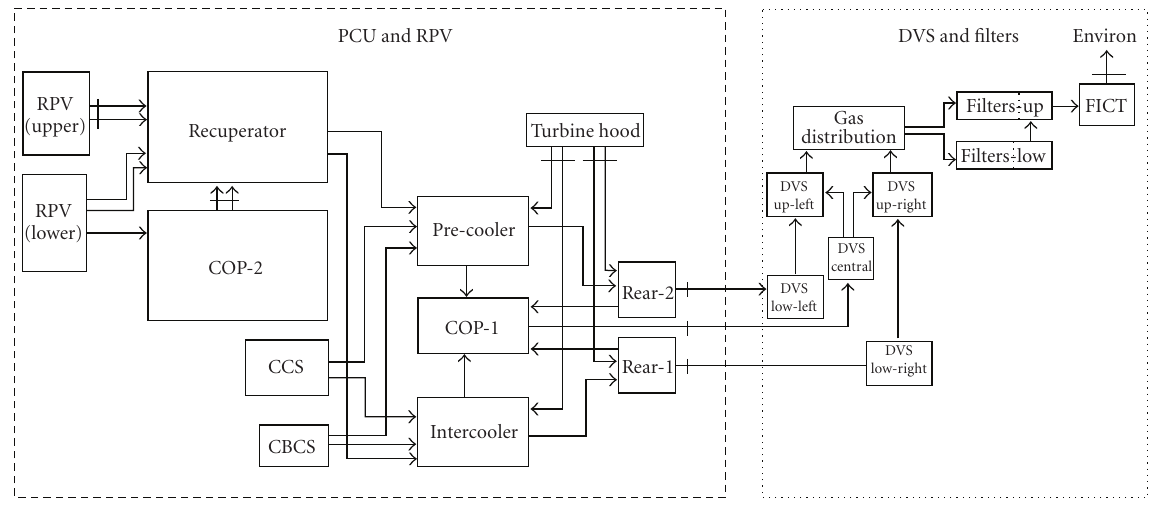
Figure 1: Diagram of the confinement building layout, including the PCU, RPV, and DVS, and the flow path connection between